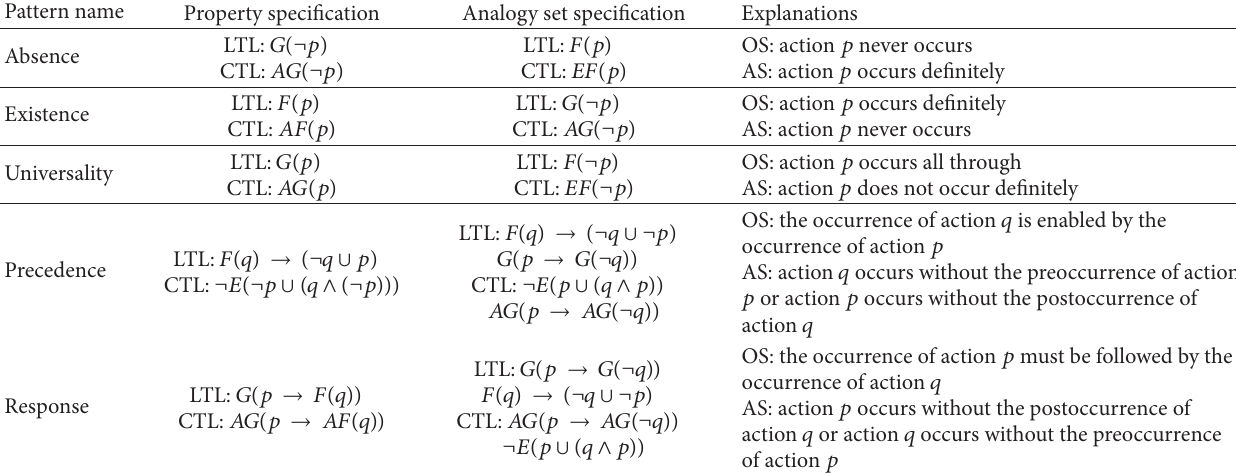
Table 1: The analogy set specifications for five property